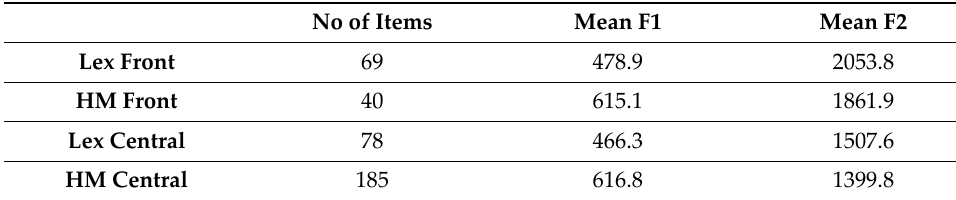
Table A1. Means for lexical and hesitation marker front and central/back vowels.